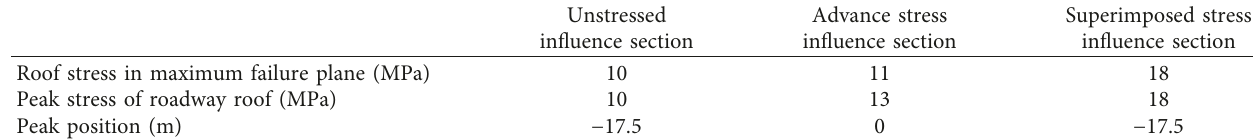
Table 2: Three stages of stress change during advance.